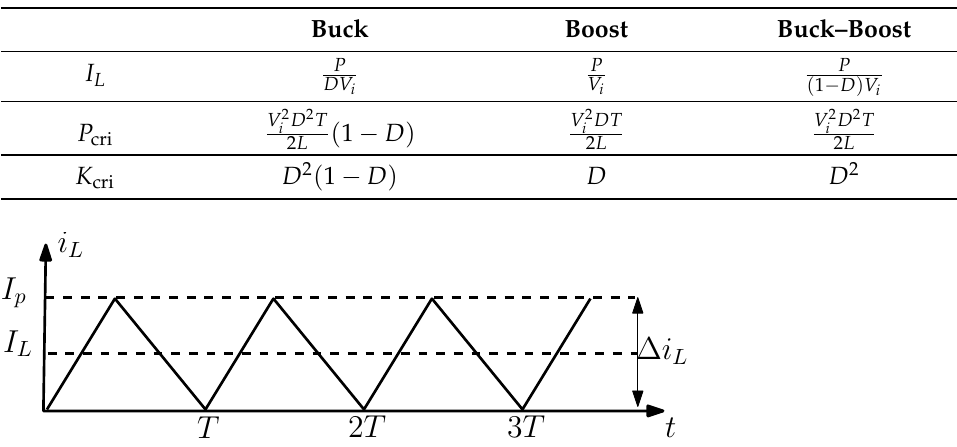
Table 3. Expressions for the steady-state value of the average inductor current I L , the critical value P cri of the power P , and the critical value K cri of the dimensionless parameter K at the boundary of CCM–DCM for the three elementary DC–DC converters operating in DCM.